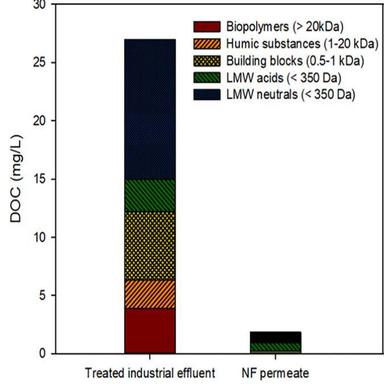
Removal of individual groups of dissolved organic carbon (DOC) including biopolymers, humic substances, building blocks, low molecular weights (LMW) acids, and LMW neutrals of paper mill industrial wastewater treatment plant (IWTP). Samples were collected and measured in October 2020.